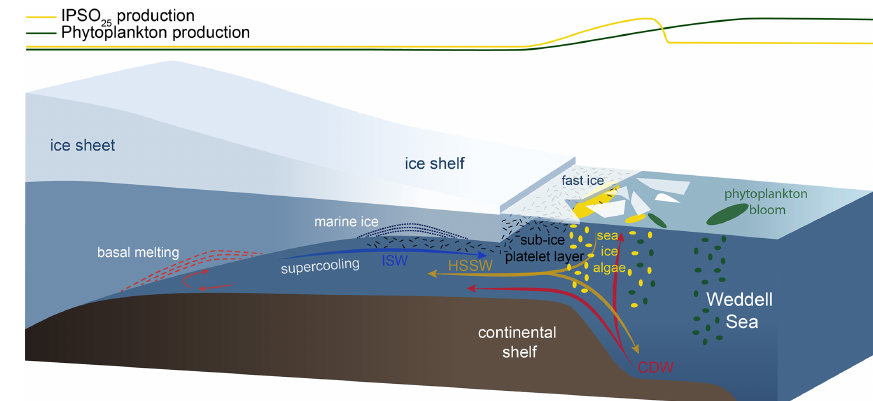
Figure 8. Schematic illustration of the formation of platelet ice and the main production areas of sea-ice algae producing IPSO 25 (yellow ellipses) and phytoplankton (green ellipses), also displayed by yellow and green curves at the top of the figure. The following abbreviations are used in the figure: CDW – Circumpolar Deep Water, HSSW – High Saline Shelf Water and ISW – Ice Shelf Water. Illustration modified from Scambos et al.